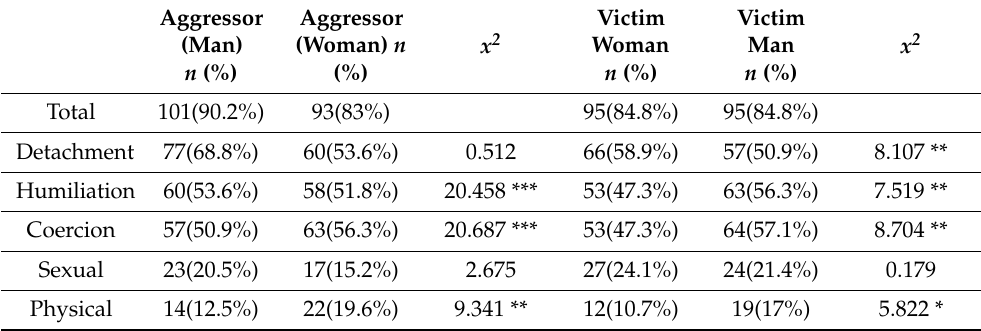
Table 3. Prevalence of the occurrence of the types of violence (DVQ-R) in violent couples according to the roles of the partners: man aggressor-woman aggressor or man victim-woman